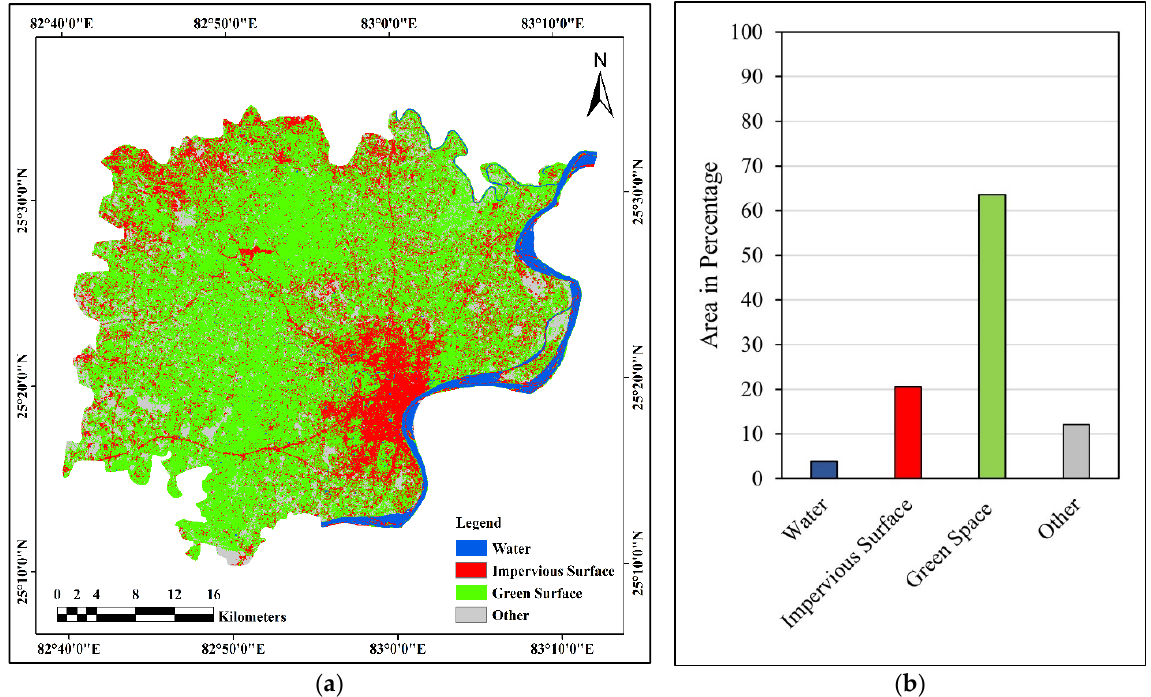
Figure 2 . ( a ) Land-use–land-cover (LULC)-classified map of Varanasi city. ( b ) Percentage-area-based division of the four LULC categories.